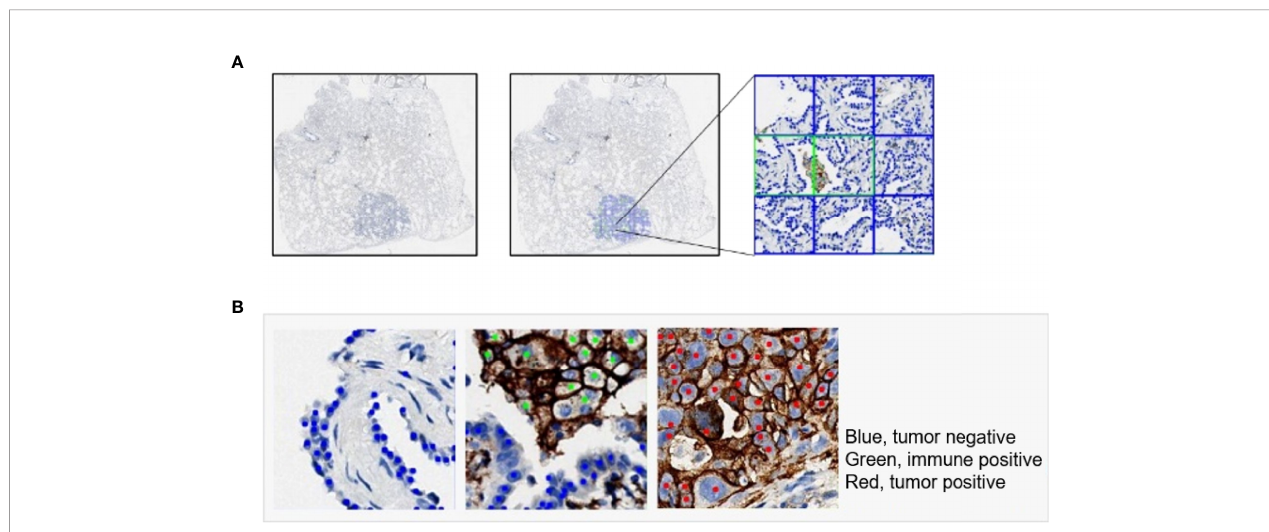
FIGURE 5 | Examples of tumor detection and PD-L1 calculation. (A) Example of whole-slide image analysis for tumor recognition with the 256 patch. (B) Examples of cells detected by the YOLO model: PD-L1-negative tumor cell (blue), PD-L1-positive immune cell (green), and PD-L1-positive tumor cell